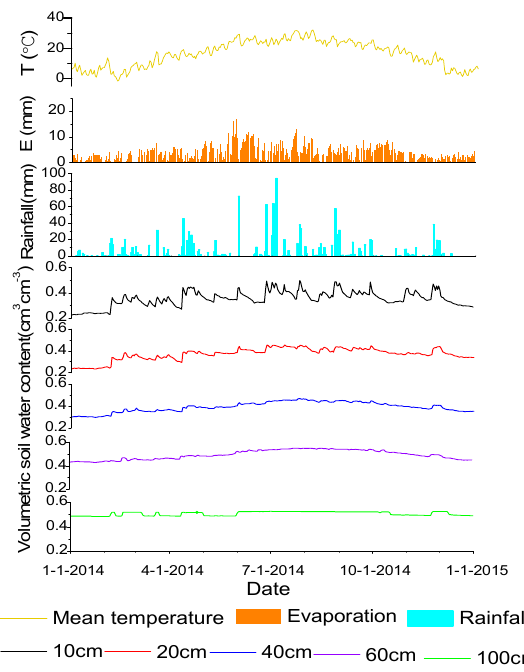
Figure 3. Daily mean temperature (°C), evaporation (mm), rainfall (mm) and volumetric soil water contents (cm 3 ·cm − 3 ) at five depths of soil layers: 10, 20, 40, 60 and 100 cm at the experimental field,